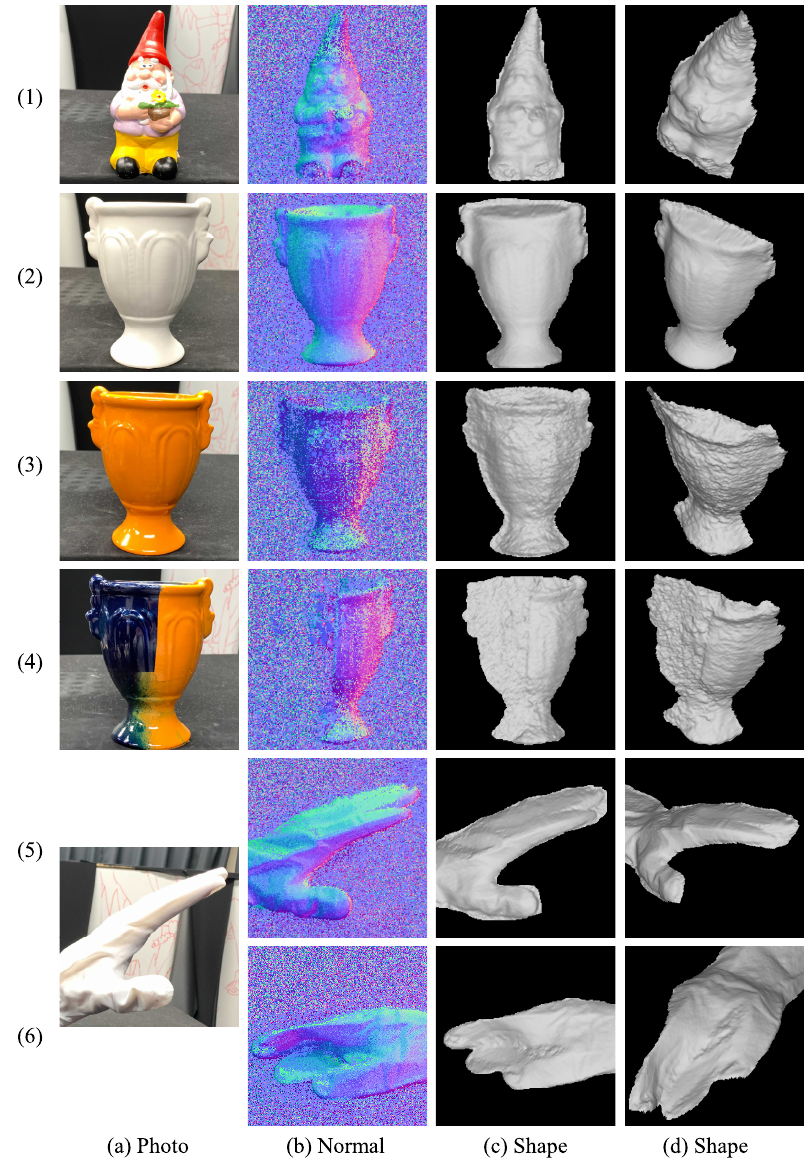
Figure 11. Experimental results of the (1) multi-colored object, (2) white object, (3) single-colored object, (4) dark object, and (5,6) deformable object: ( a ) Target object, ( b ) estimated surface normal, and ( c , d ) reconstructed